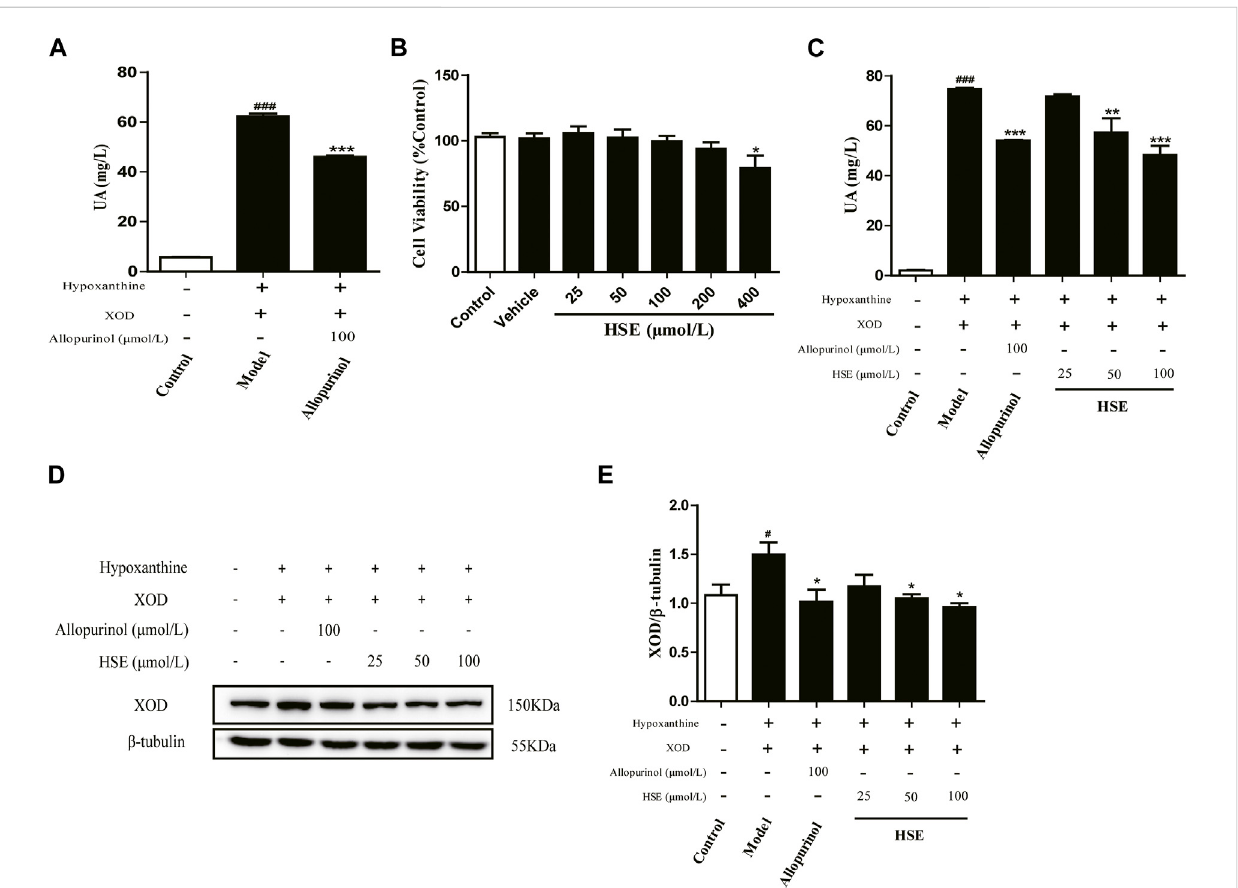
FIGURE 8 Hesperetin (HSE) inhibited the production of uric acid (UA) in vitro . Establishment of a high uric acid (UA) model in cells (A) and effects of hesperetin (HSE)ontheviabilityofL-O2cells (B) ;Uricacid(UA)level (C) ;thebandofXODprotein (D) andquantitativeanalysis (E) .L-O2cellswereseededinsix-well plates overnight, incubated with 2 mL of hesperetin (HSE) (25, 50, or 100 μ mol/L) or allopurinol (100 μ mol/L) for 24 h, followed by incubation with hypoxanthine (800 μ mol/L) for 24 h and addition of xanthine oxidase (4 μ L/well). Data are the mean ± SEM (n = 3) and representative of three independent experiments. # p < 0.05 and ### p < 0.001 versus the control group; * p < 0.05, ** p < 0.01 and *** p < 0.001 versus the model group. HSE, hesperetin; UA, uric acid; XOD, xanthine